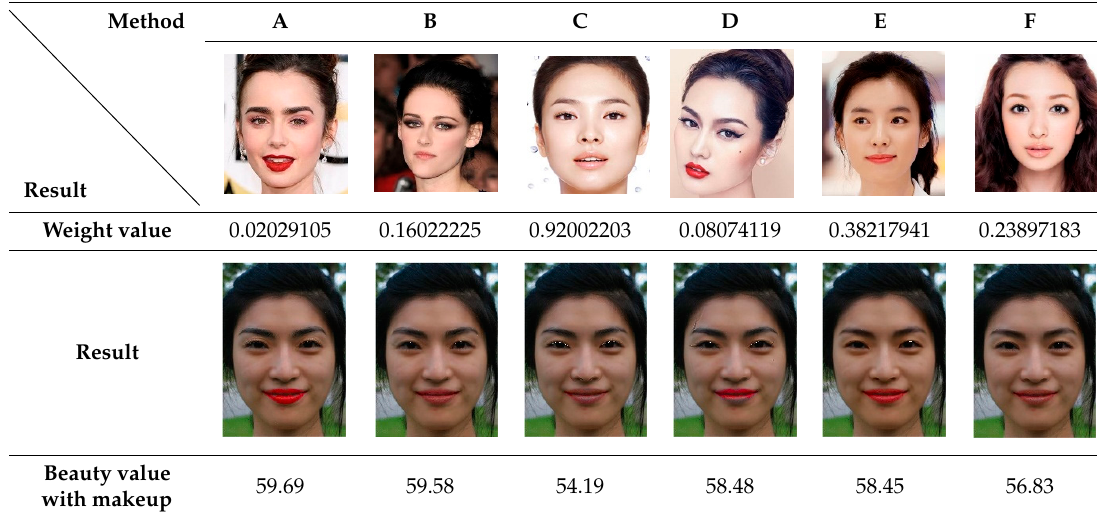
Table 5. The same girl wears different makeups.